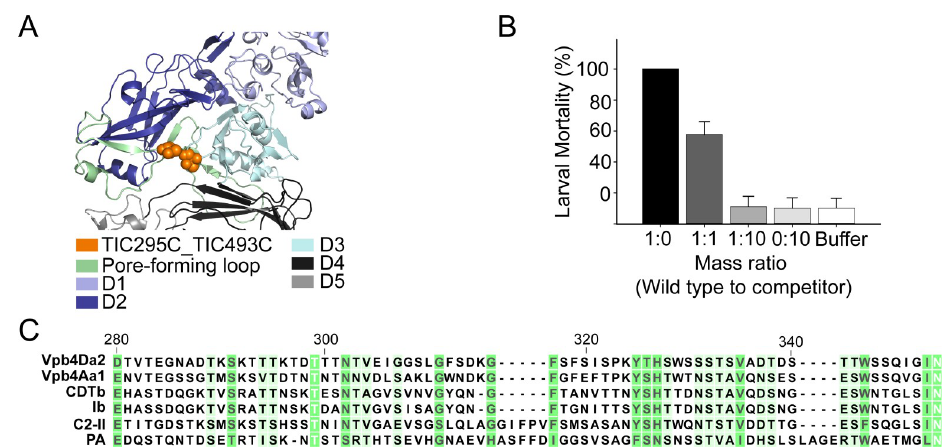
Fig 6. Competition bioassay evaluation using the pore-forming disabled variant. (A) Structural representation (PyMOL ™ 2.0.2) of the Vpb4Da2 pore-forming loop within domain 2 (pale green) and amino acid substitutions (orange spheres) representing the disabled insecticidal protein (DIP) variant. Domains D1-D5 are also represented. (B) Mass action in vivo competition bioassay. Wild-type Vpb4Da2 was competed with increasing challenge ratio of the Vpb4Da2-DIP variant. Bars represent the mean percent larval mortality with standard error. Mean values with same letter are not statistically different (One Way ANOVA Student-Newman-Keuls’ test, α = 0.05). (C) Multiple sequence alignment of the Vpb4Da2 pore-forming loop and selected β − PFPs from the Bacterial_exotoxin_B family using CLCBio ™ version 7.6.4. Numbers on sequences are relative to Vpb4Da2. The degree of sequence conservation is represented by a green background